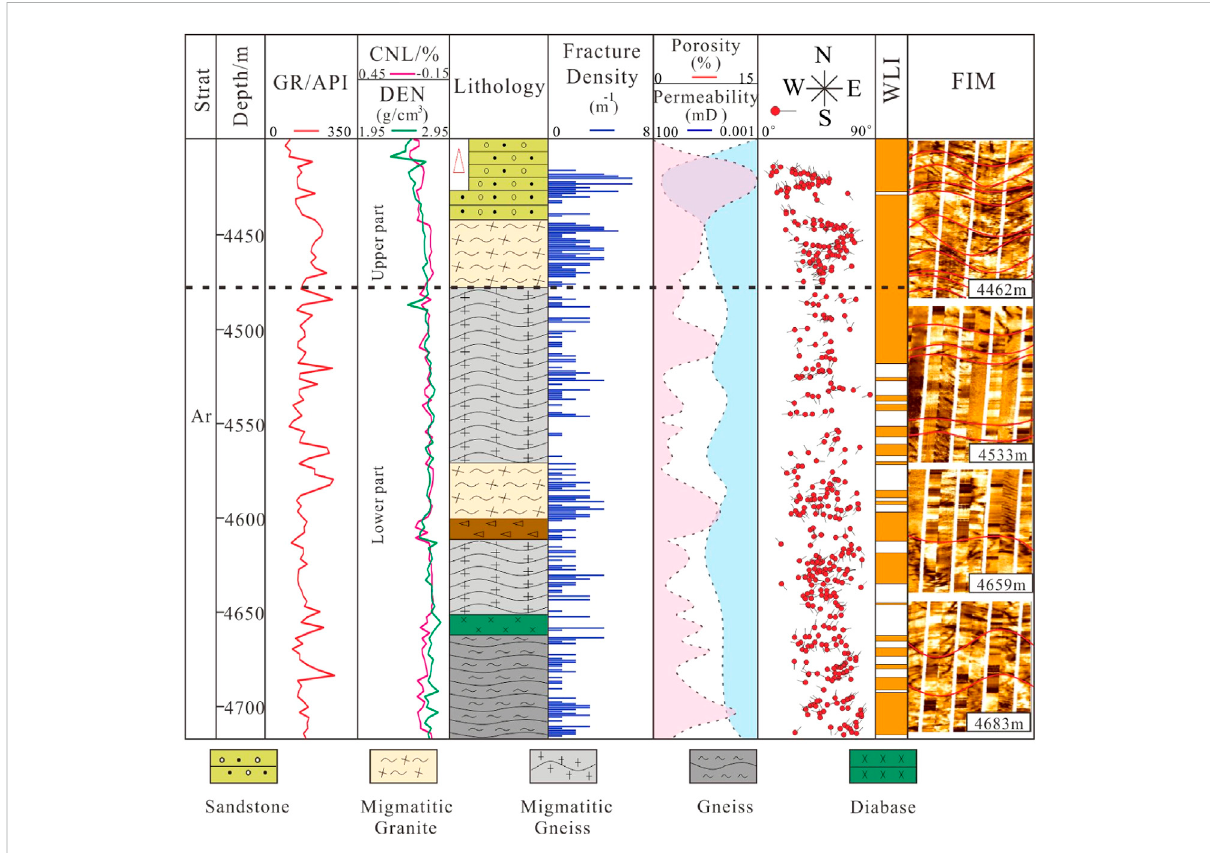
FIGURE 6 Fracture characteristics of the comprehensive columnar section from well